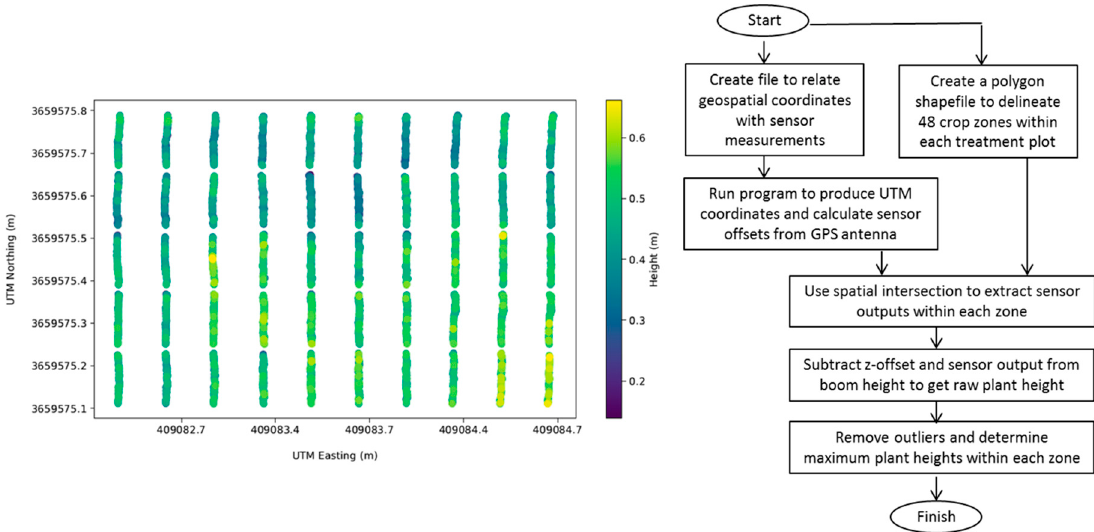
Figure 3. Flow chart for nadir view sensors (ultrasonic transducers and Lidar Lite V3) data processing with an example output of raw plant heights georeferenced by the UTM coordinates from the 2017 DOY191 Pepperl+Fuchs sensors.